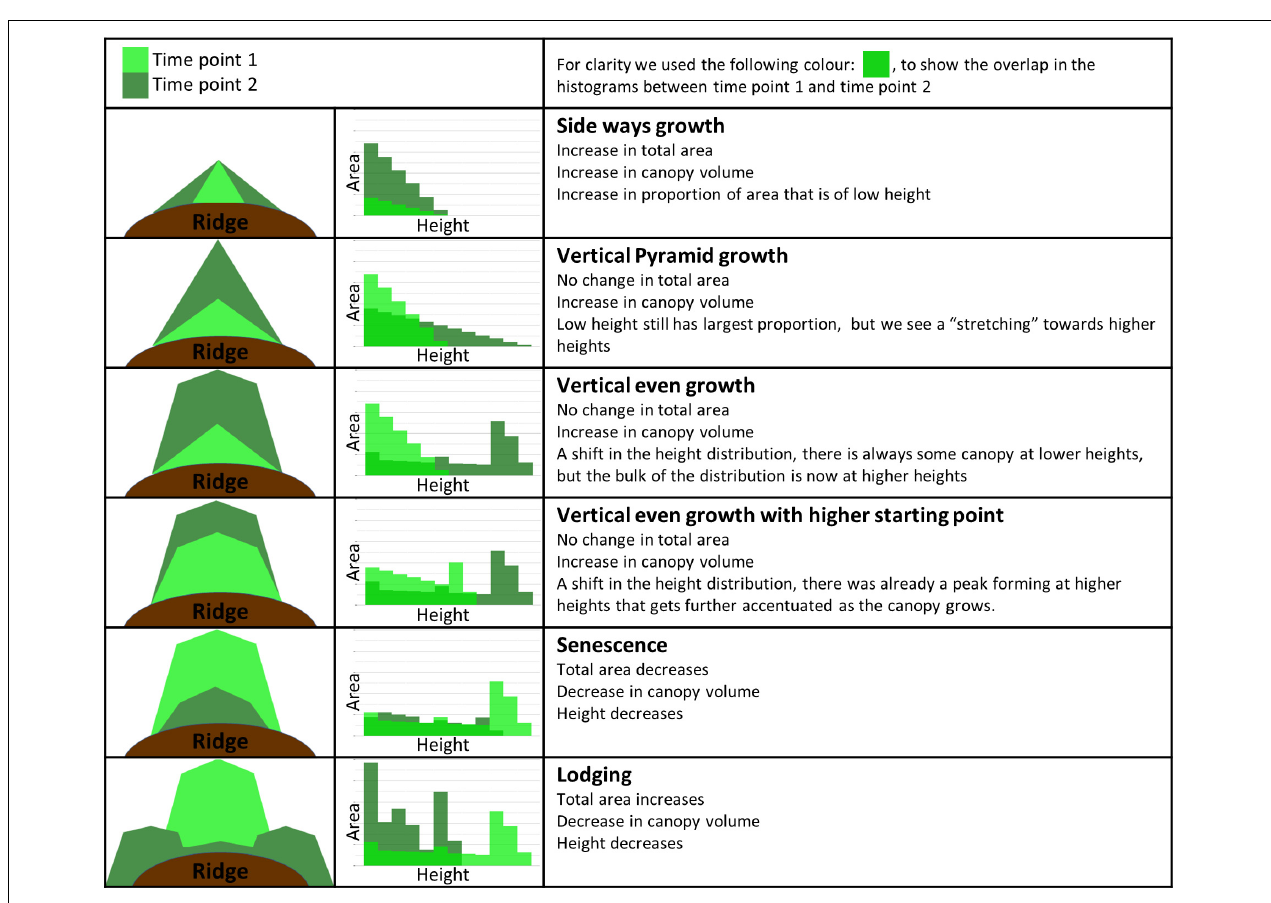
FIGURE 8 | Guide to interpretation of canopy development data at two time points. Column 1 shows a diagrammatic representation of the canopy side profile with the corresponding height distribution histograms located in column 2 (simulated data). Time points 1 and 2 are shown in light green and dark green, respectively. Column 3 defines the name given to each growth pattern, followed by a brief description of the most relevant changes between the two time